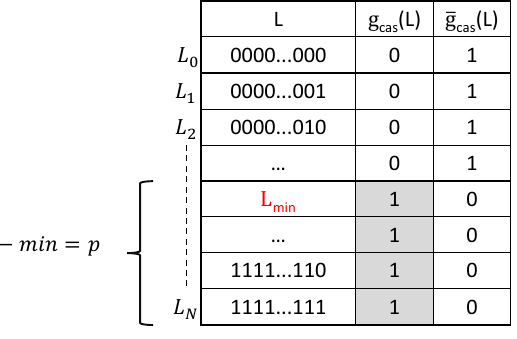
Figure 4: A truth table for g cas and ¯ g cas , where L min stands for the smallest input pattern that makes the Boolean function g cas equal to